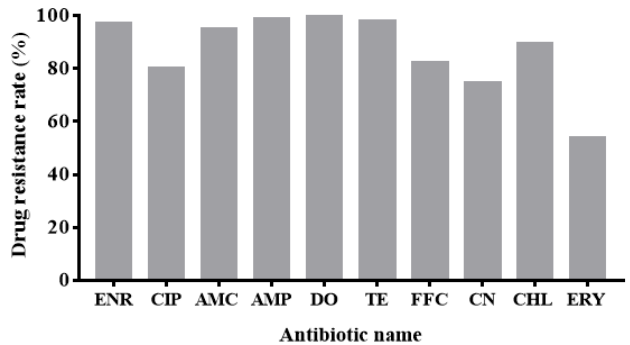
Figure 2. The resistance rates of 107 strains of E. coli to 10 kinds of antibiotics.